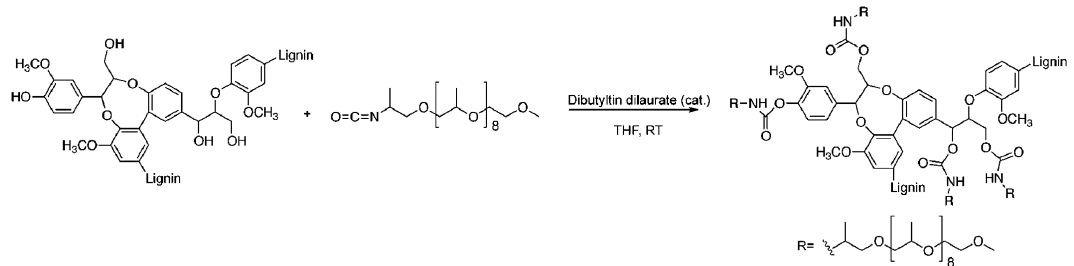
Figure 38. Polyurethane synthesis from lignin and an isocyanate-terminated poly(propylene oxide) macromonomer. Reproduced with permission [128].